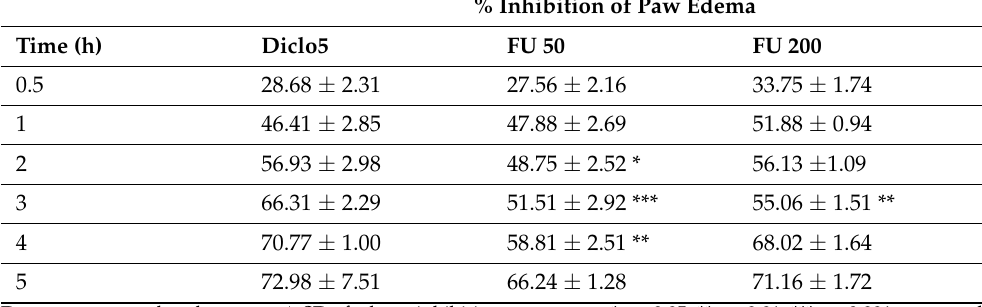
Effects of sodium diclofenac and F. umbellatta extracts on carrageenan induced acute